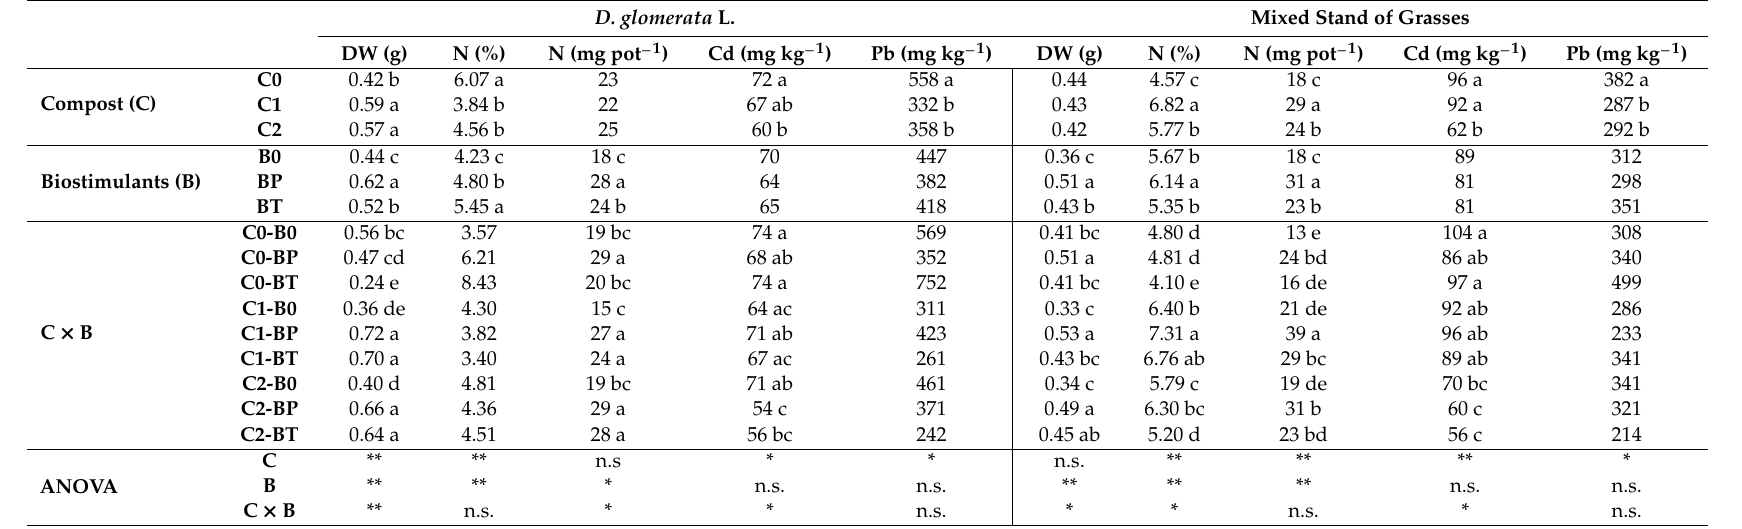
Table 4. Plant biomass (DW), nutrient status (N content) and PTE concentrations in shoots of D. glomerata L. and in a mixed stand of F. arundinacea Shreb. , L. perenne L. and P. pratensis L. C0 = no compost, C1 = 0.7%, C2 = 1.4%; B0 = no biostimulants, BP = Panoramix, BT = Trianum-P. Mean values within columns and factor with the same letter do not di ff er according to the LSD test ( p < 0.05); * p < 0.05; ** p < 0.01; n.s., not